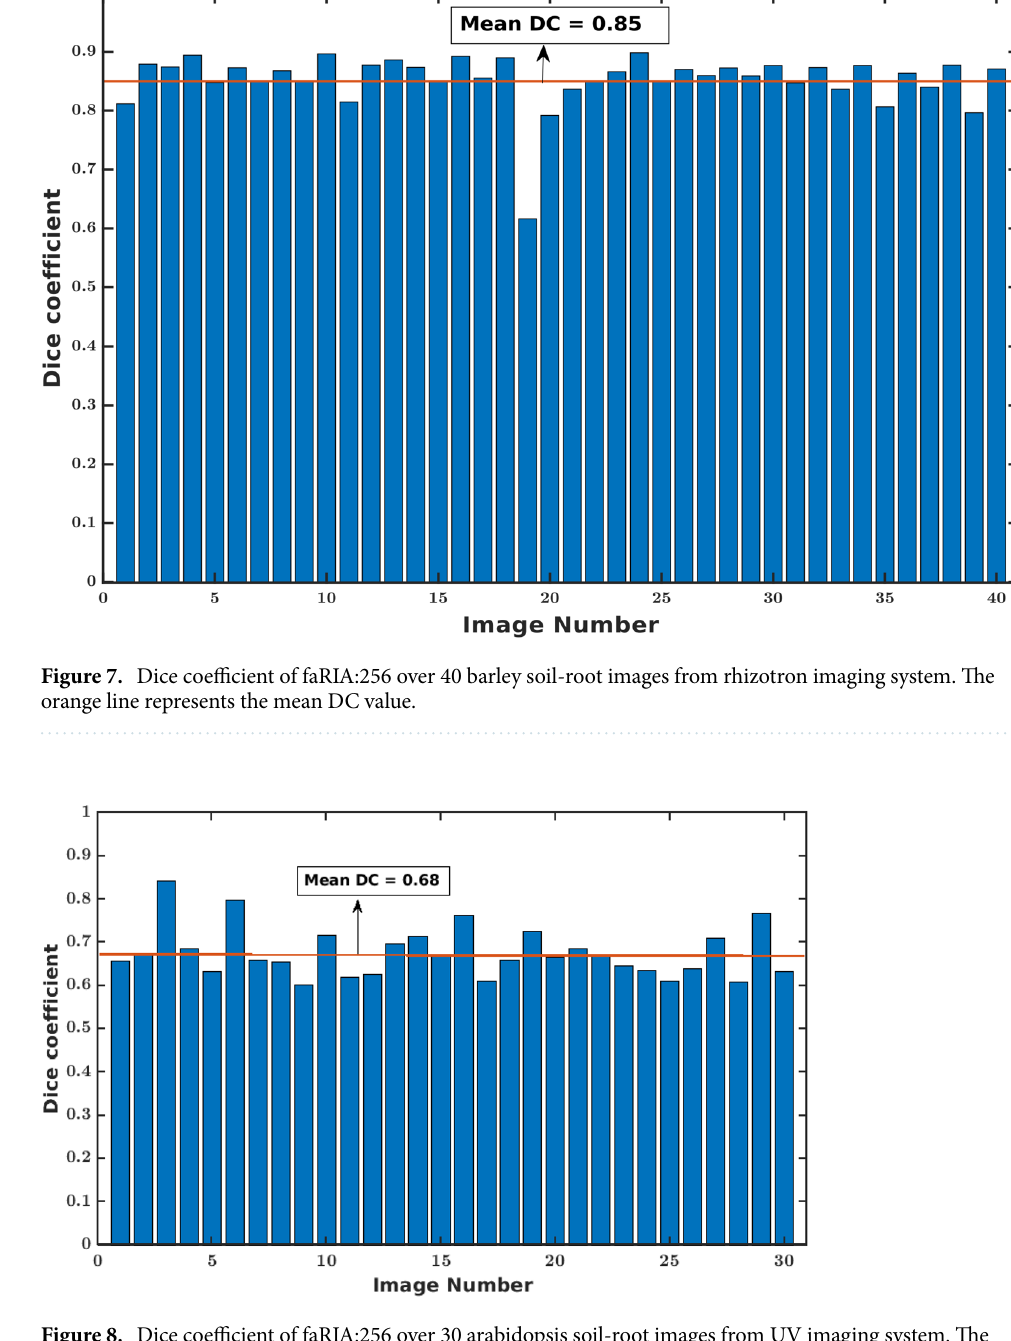
Figure 8. Dice coefficient of faRIA:256 over 30 arabidopsis soil-root images from UV imaging system. The orange line represents the mean DC